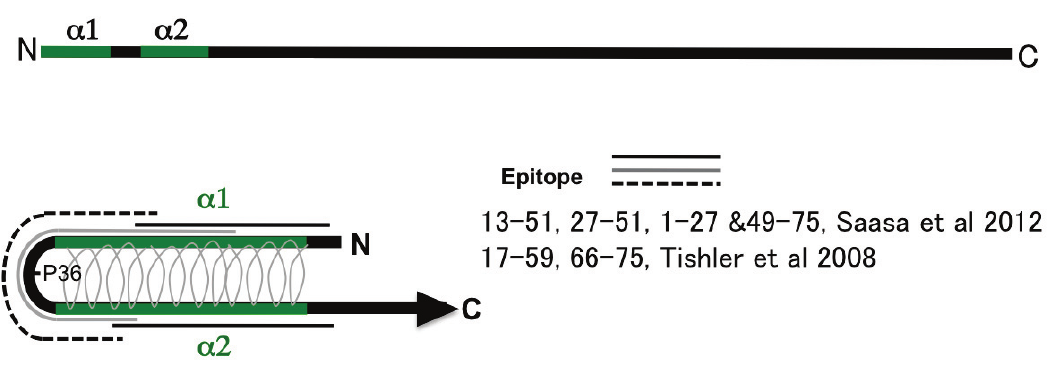
Figure 1. Schema of the structure of the N terminus of hantavirus N and epitope